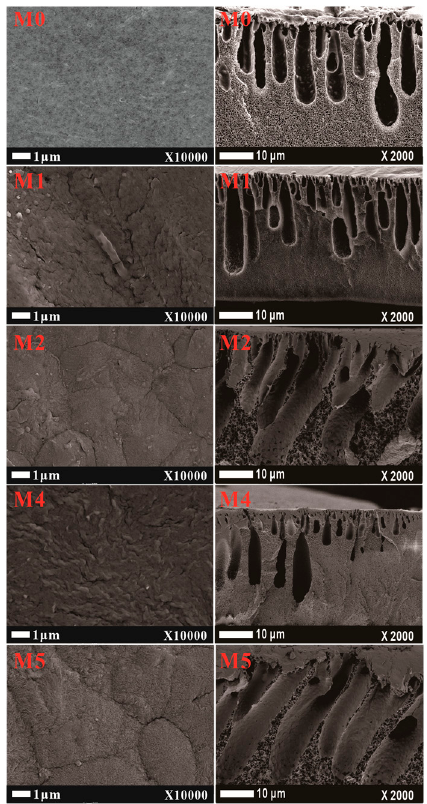
Figure 5. The SEM surface and cross-section images of PVDF composited membranes with oriented or unoriented mCNTs grafting single and diblock chains. (The M0, M1, M2, M4, and M5 sample information is listed in Table 1.)